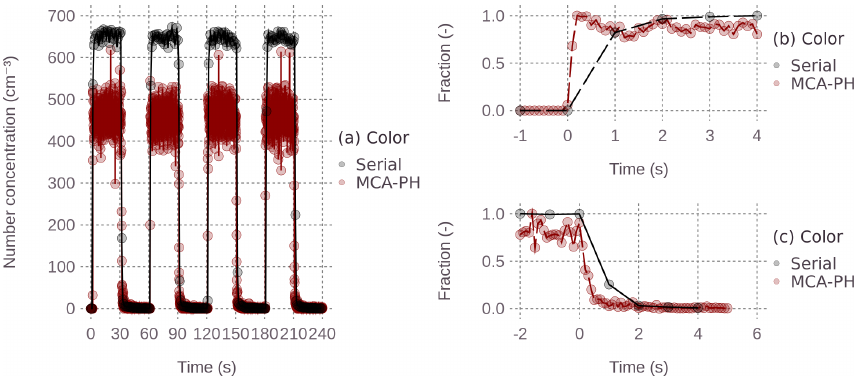
Figure 7. (a) Time response curves were measured by the POPS data acquisition system and MCA data acquisition system. Right: zoomed-in view for one example up (b) and down (c) cycle. Time t = 0s corresponds to the valve switch.